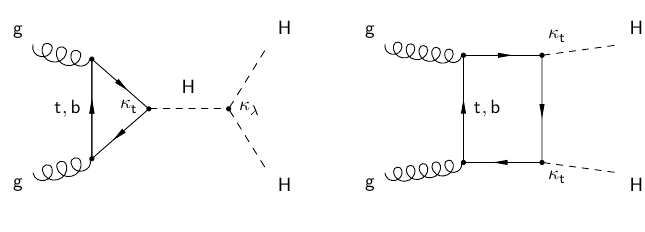
Figure 1 . Feynman diagrams for Higgs boson pair production via gluon fusion in the SM. The coupling modi(cid:12)ers for the Higgs boson self-coupling and the top quark Yukawa coupling are denoted by (cid:20) (cid:21) and (cid:20) t ,